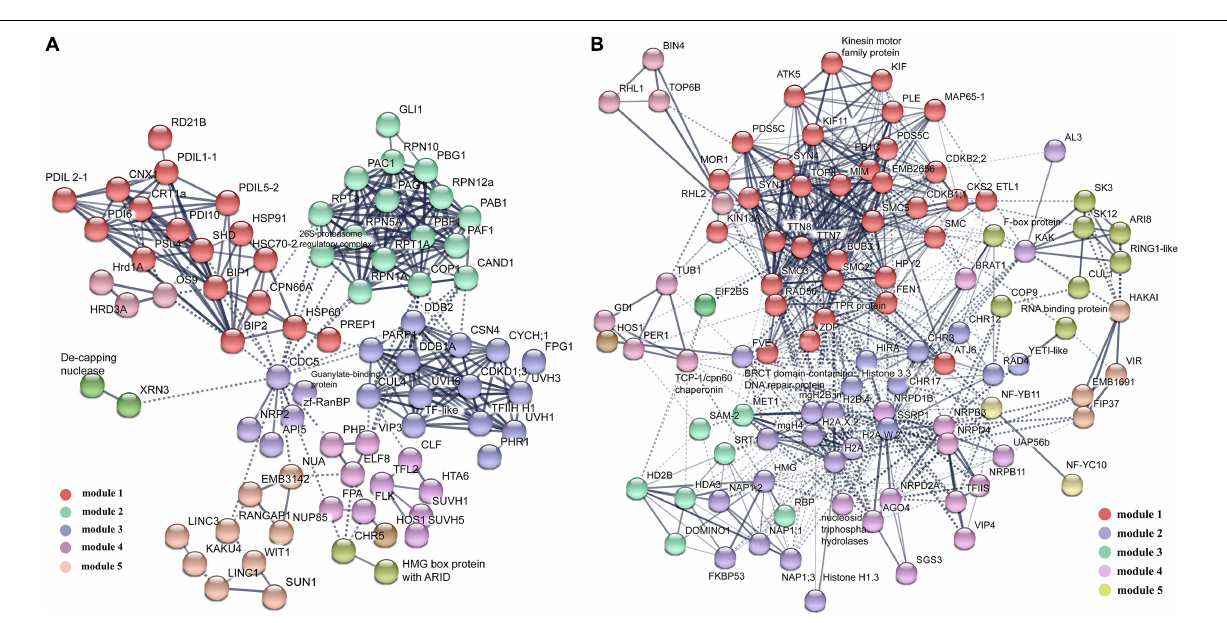
FIGURE 4 | The protein–protein interaction (PPI) network in VN and GN revealed by STRING analysis. (A) Among 379 DAPs highly expressed in VN, 88 proteins were analyzed, except proteins involved in metabolism and RNA processing. (B) Among 341 DAPs highly expressed DAPs in GN, a total of 101 proteins were analyzed, except proteins involved in ribosome assembly and translation processes. The networks were generated with protein interactions score > 0.7 and MCL inflation parameter 3. Different modules were indicated in different colors. For the PPI networks of excluded proteins, see Supplementary Figures